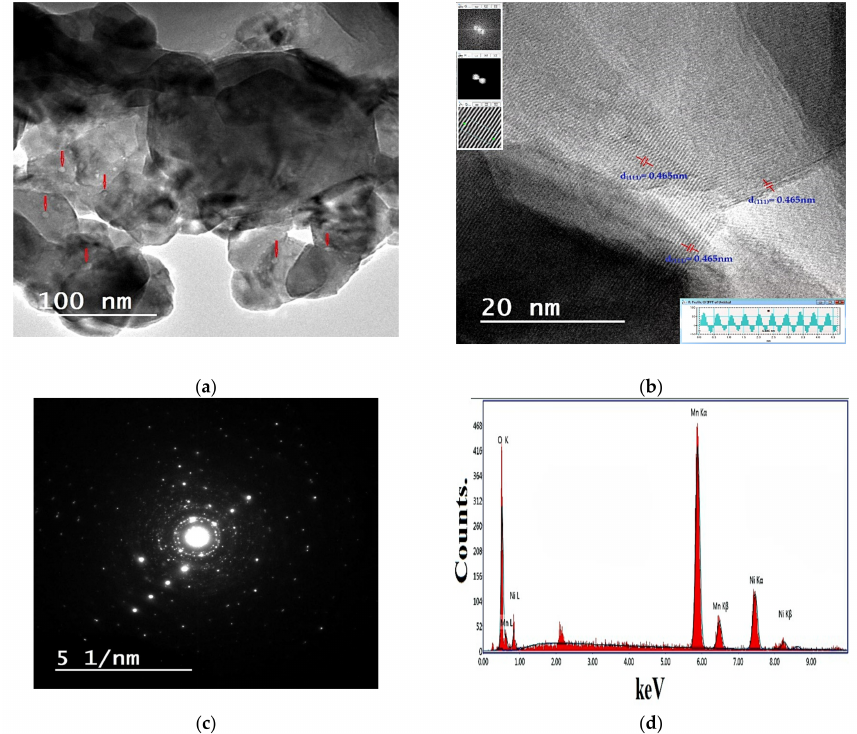
Figure 4. (( a ): HRTEM, ( b ): FFT, ( c ): SAED and ( d ): EDX) images of the S1.